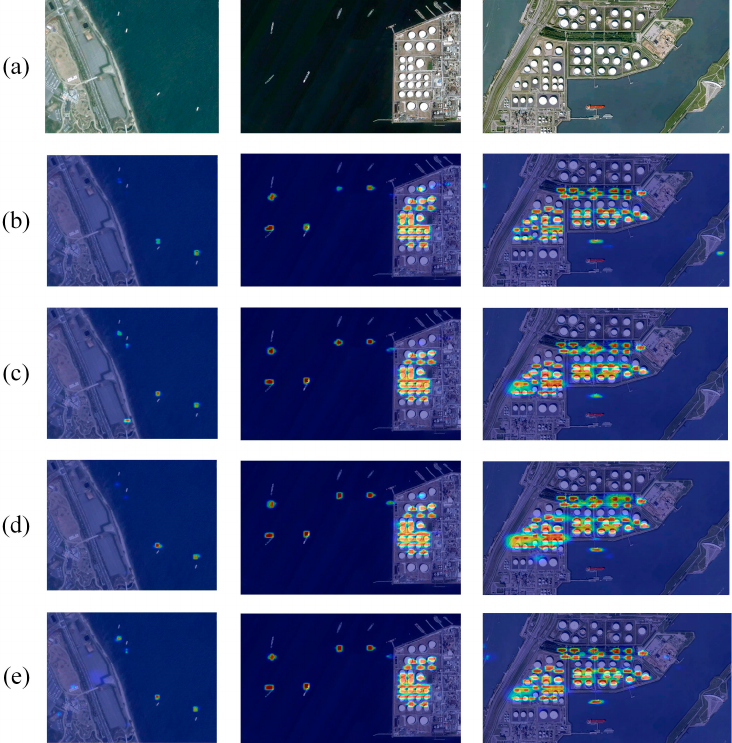
Figure 9. Visualization results of improved feature detection: ( a ) input image; ( b ) visualization results for YOLOX; ( c ) visualization results of adding 160 × 160 channels for YOLOX; ( d ) visualization results of adding Res-RFBs for YOLOX; ( e ) visualization results of adding 160 × 160 channels and Res-RFBs for YOLOX. Table 3. Experimental results in the NWPU VHR-10 dataset. FPS stands for frame per second and mAP stands for mean average